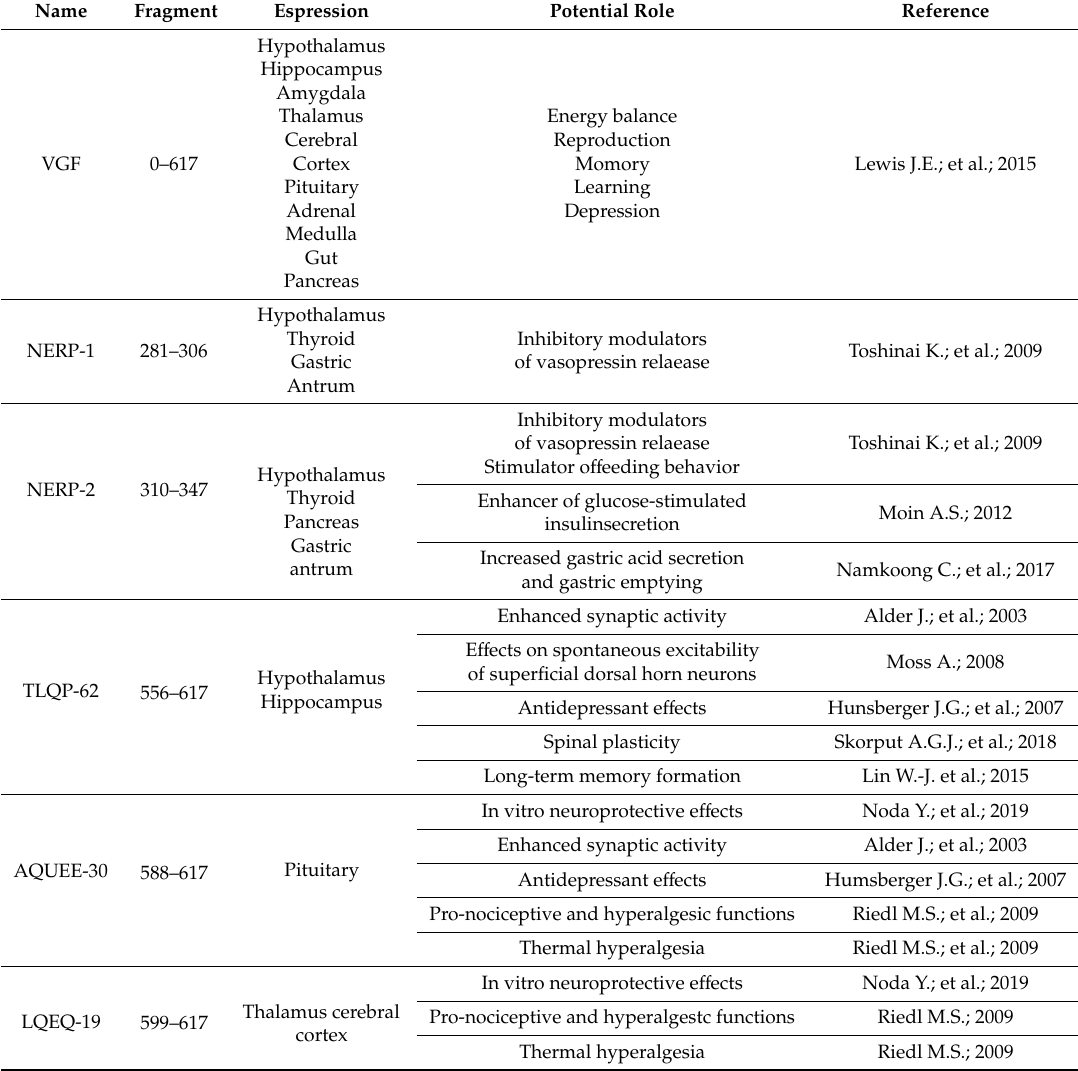
Table 1. VGF and derived